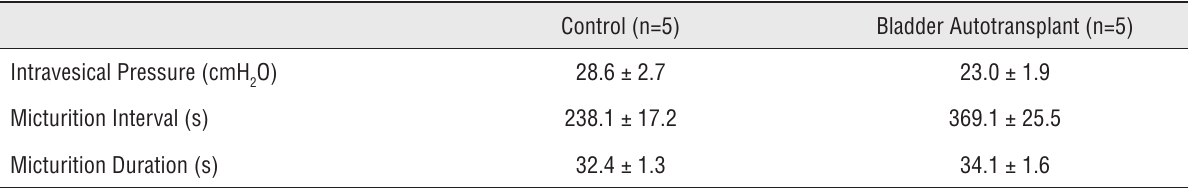
Table 1 - Cystometric values in female Wistar rats that underwent urinary bladder